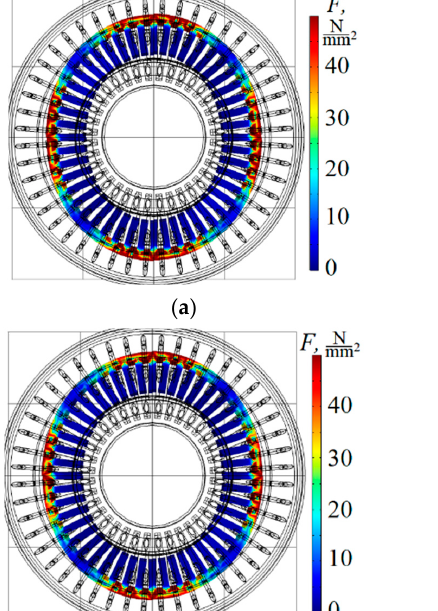
I A = 1.4 · I B = 0.8 · I C .